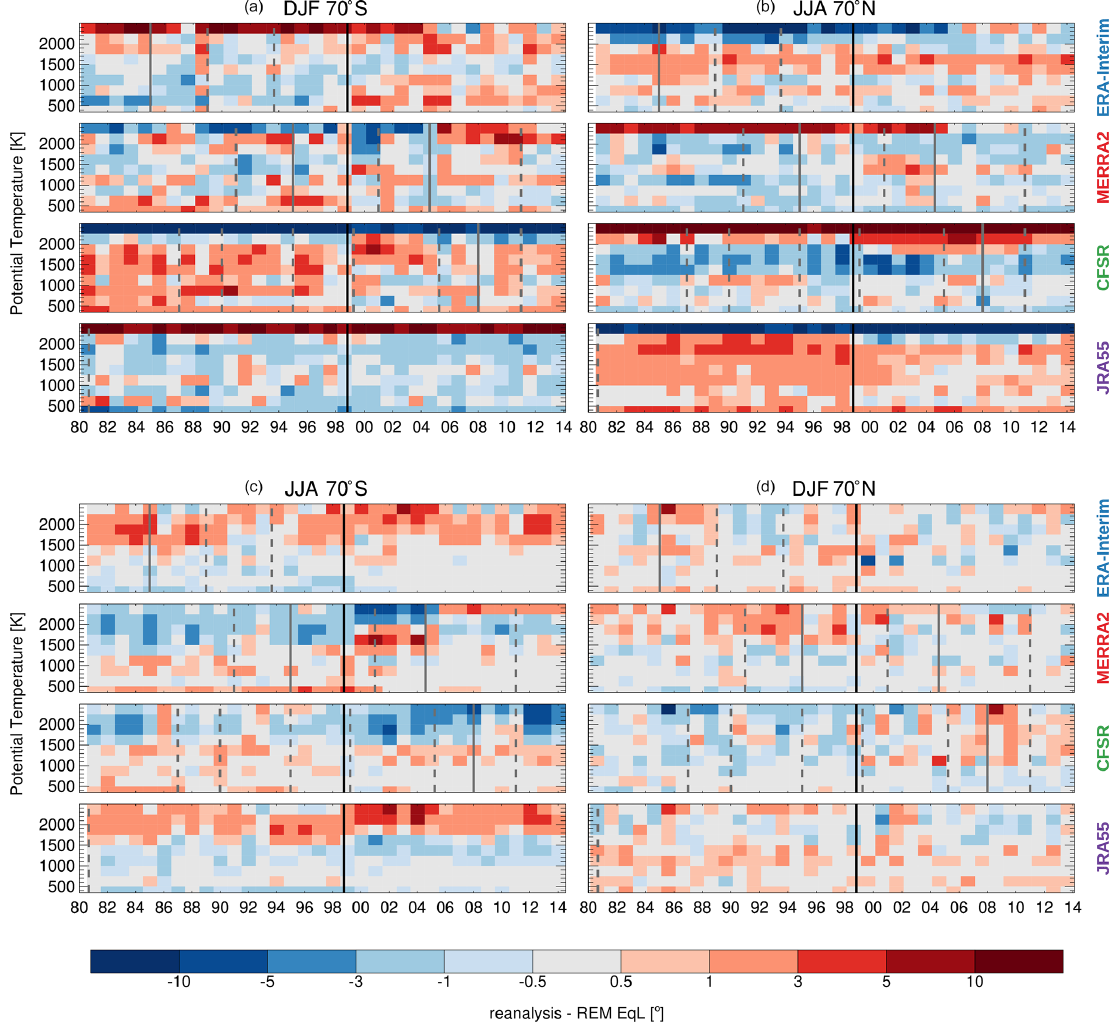
Figure 7. EqL differences for each reanalysis from the REM as a function of year and potential temperature. (a, b) Summer hemispheric differences, (c, d) winter hemispheric differences at 70 ◦ S and 70 ◦ N. Vertical lines show the discontinuities associated with changes in assimilated datasets (solid lines) or different processing streams (dashed